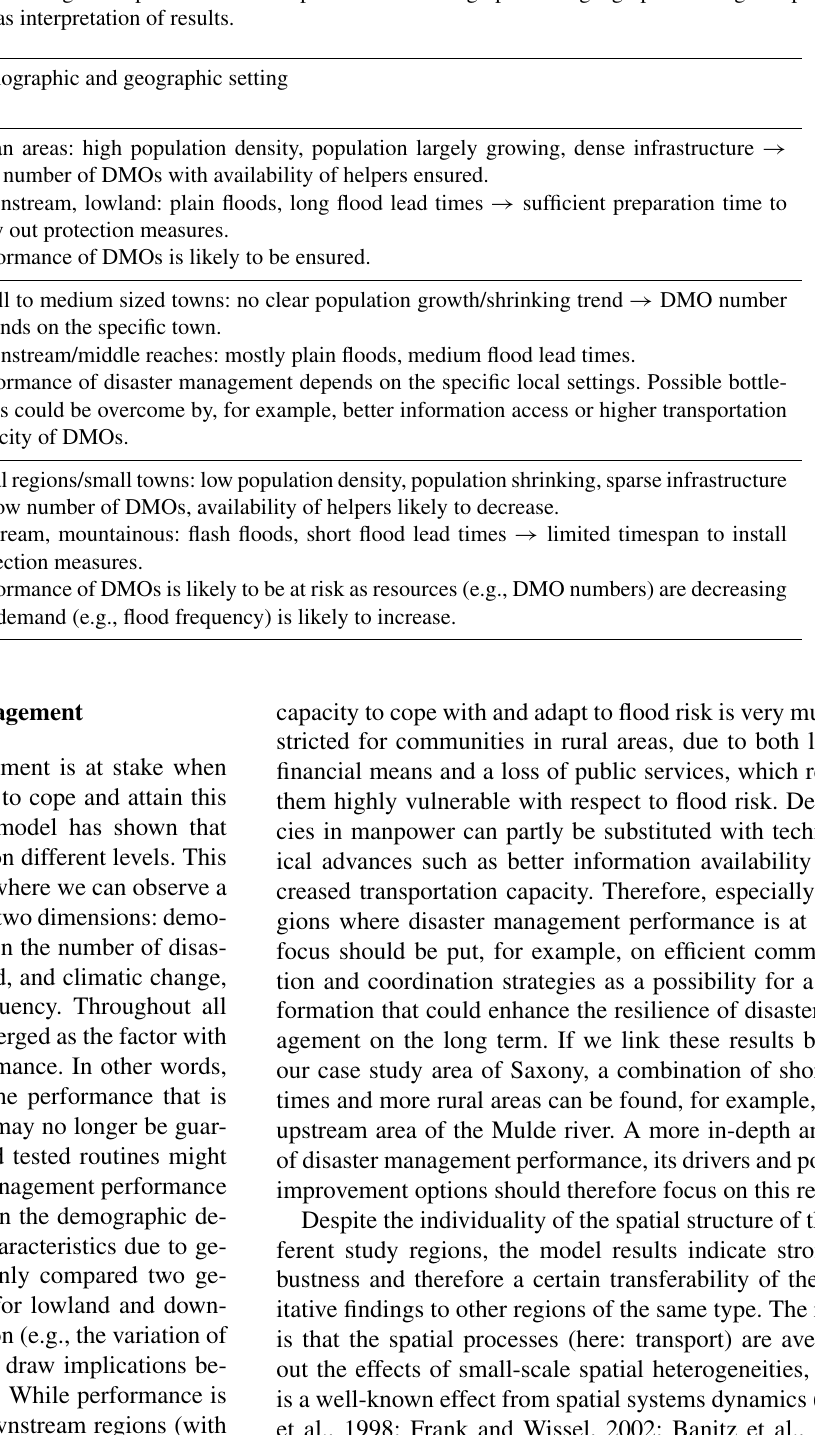
Table 3. Possible implications for disaster management performance in dependence of demographic and geographic settings. Implications are based both on model analysis as well as interpretation of